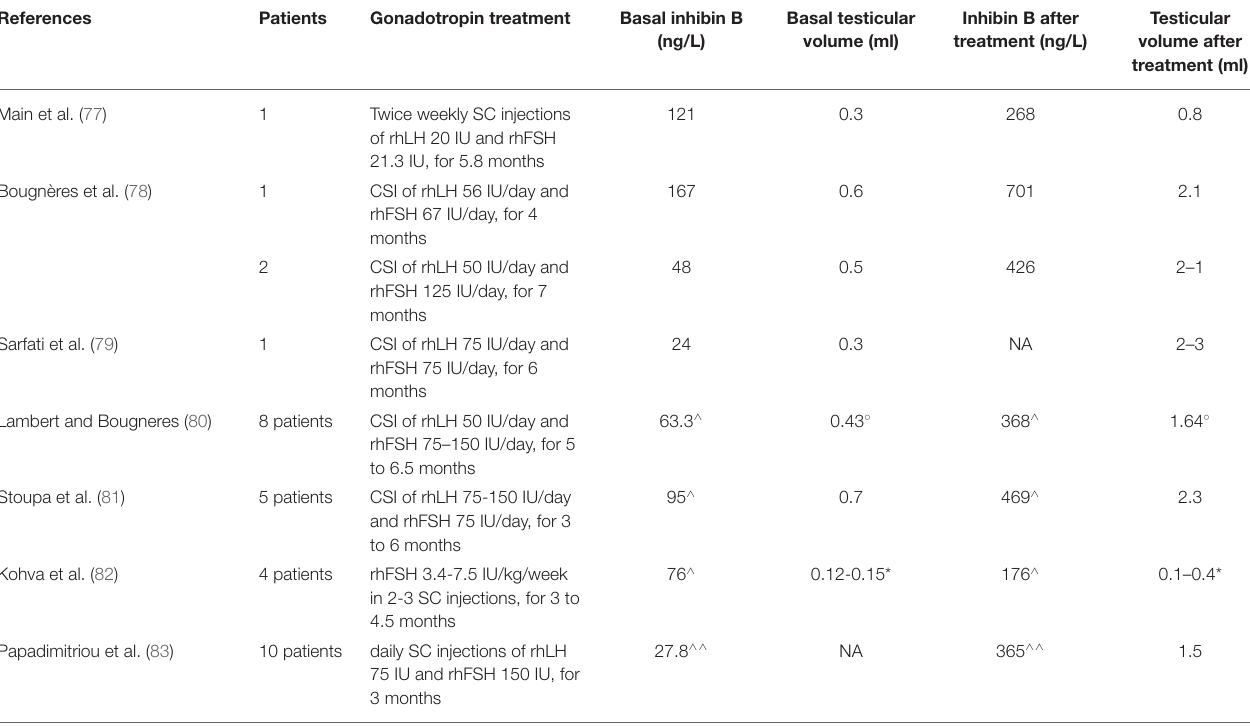
Patients Gonadotropin treatment Basal inhibin B